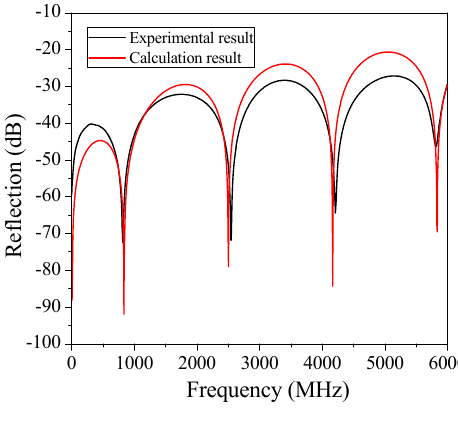
Figure 4. Measured and simulated interferogram of a